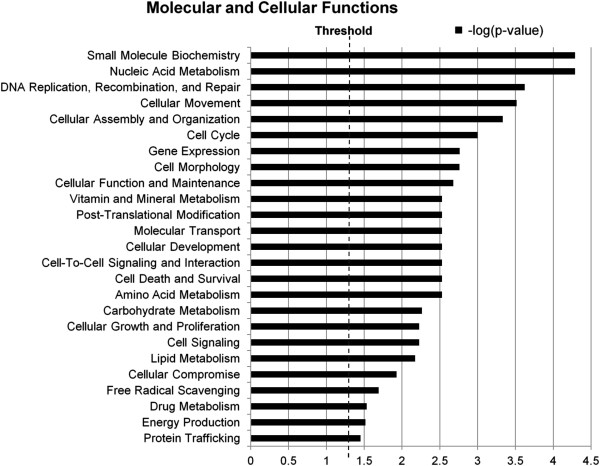
Molecular and cellular functions of protein coding genes that host AT core miRNAs. The likelihood of the association between the genes and a biological function is represented as –log(p-value), with larger bars being more significant than shorter bars. The vertical line indicates the cutoff for significance (p-value of 0.05). AT core miRNAs consist of miRNAs detected in the subcutaneous adipose tissue of all steers.